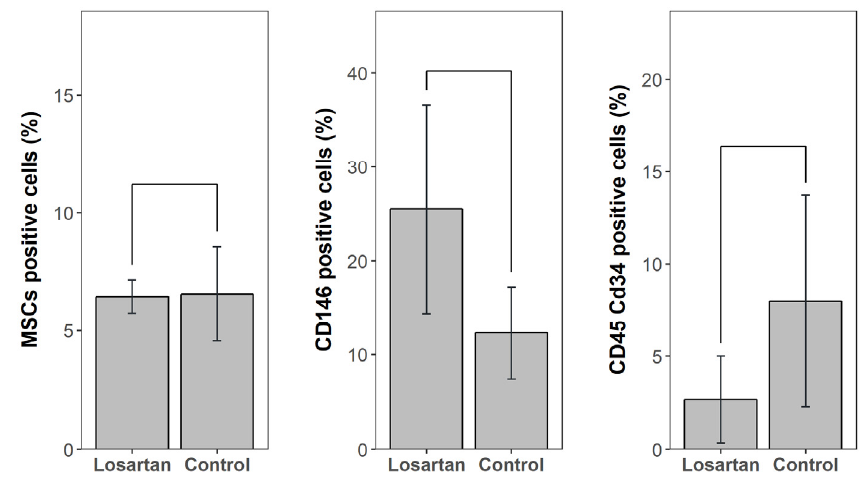
Figure 3. Mesenchymal stem cells (MSCs), CD146+ cells and CD45+ CD34+ cells in bone marrow concentrate (BMC) comparing the losartan group to the control group. Results were not statistically different between groups.